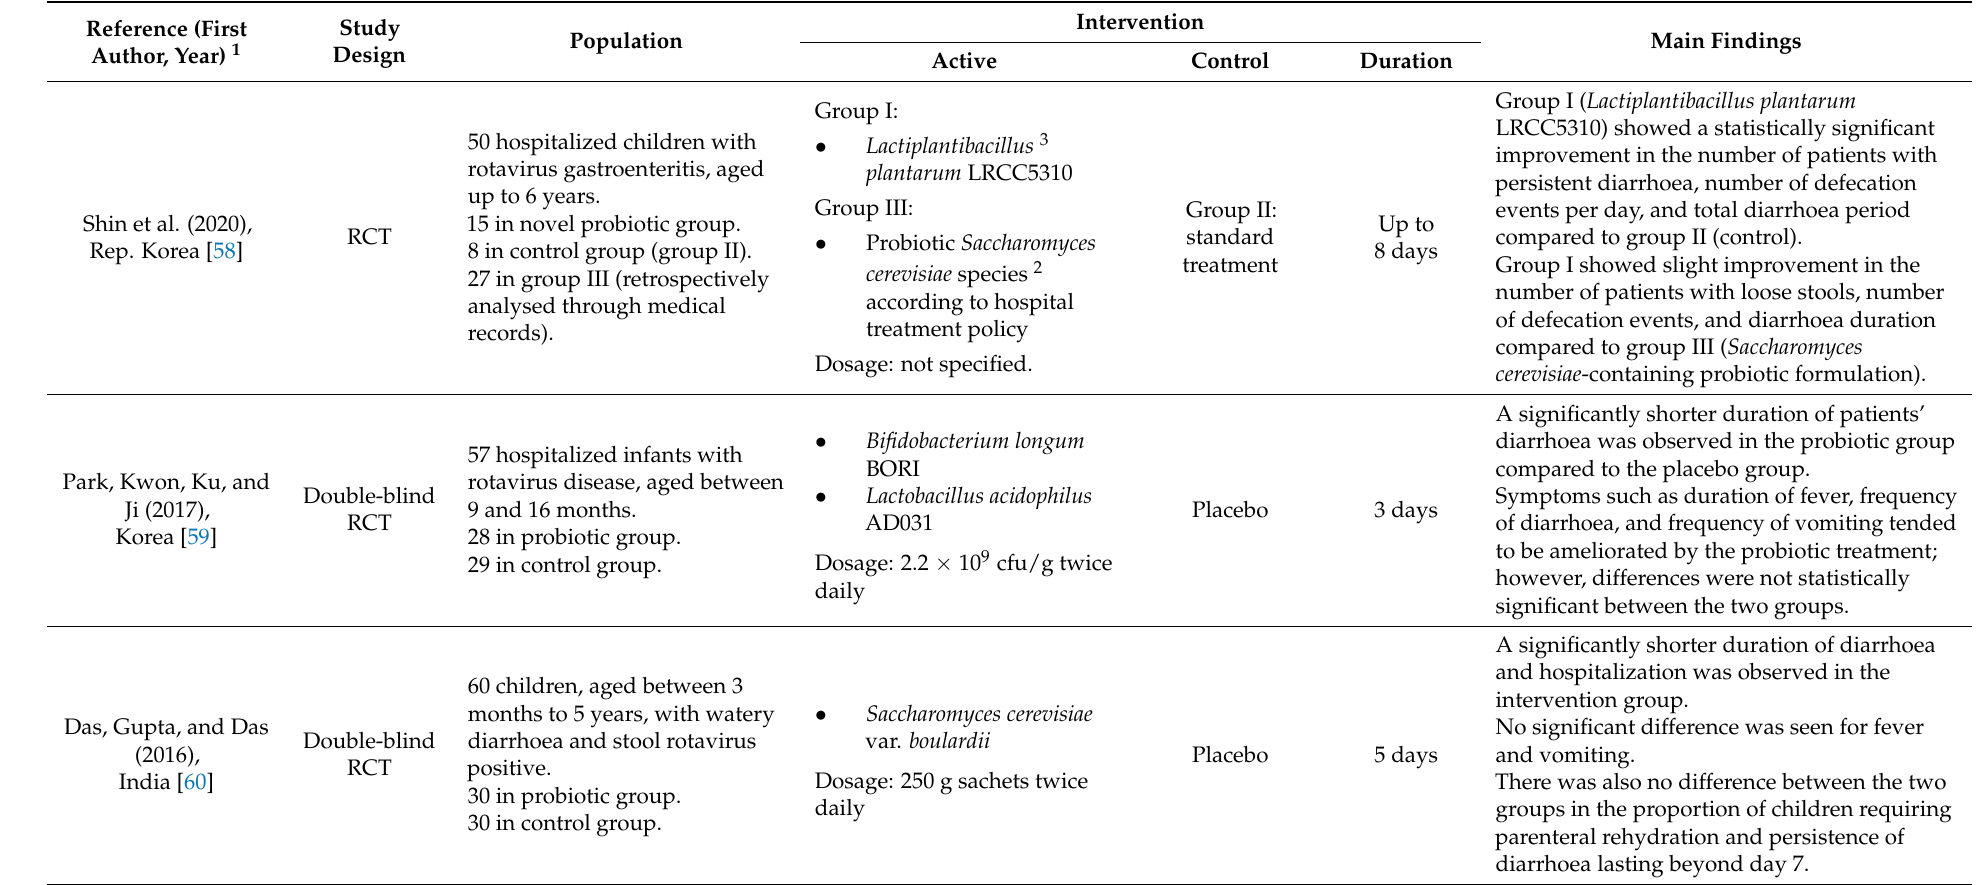
Table 1. Characteristics of 19 clinical studies with statistically significant antiviral effects of probiotics against